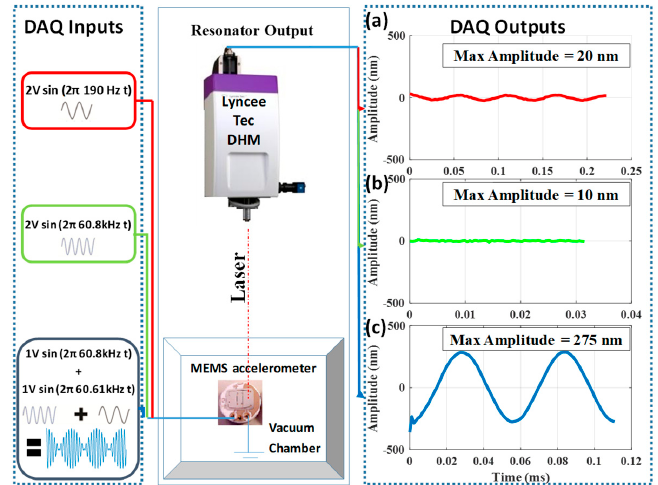
Figure 5. The experimental out-of-plane deflection of the resonator for three different cases. ( a ) Close to the mechanical resonance frequency, a sinusoidal signal of 190 Hz and 2 V of amplitude generates a deflection amplitude of 20 nm. ( b ) Relatively close to the electrical resonance of the circuit, a sinusoidal signal of 60.8 kHz and 2 V of amplitude generates a deflection amplitude of ~10 nm (within noise of the measurement). ( c ) A mixed signal composed of two frequencies: 60.8 kHz and 60.61 kHz, each with 1 V of amplitude, generates a deflection amplitude of 275